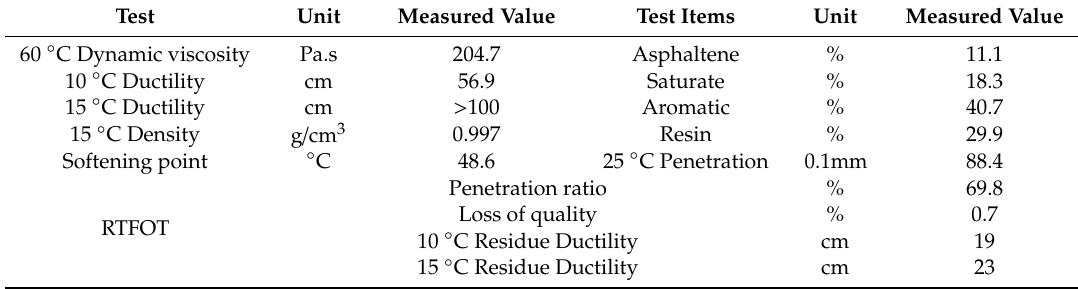
Table 1. A-90 bitumen technical indicators.